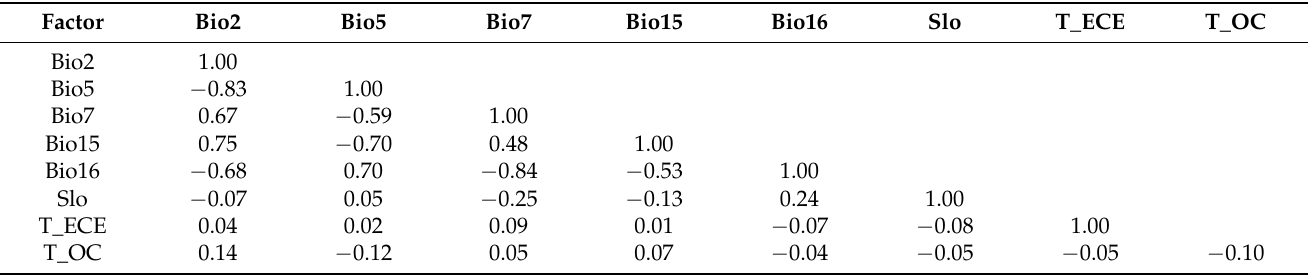
Table A3. Multi-collinearity test by utilizing correlations among climate variables for R. praestans .